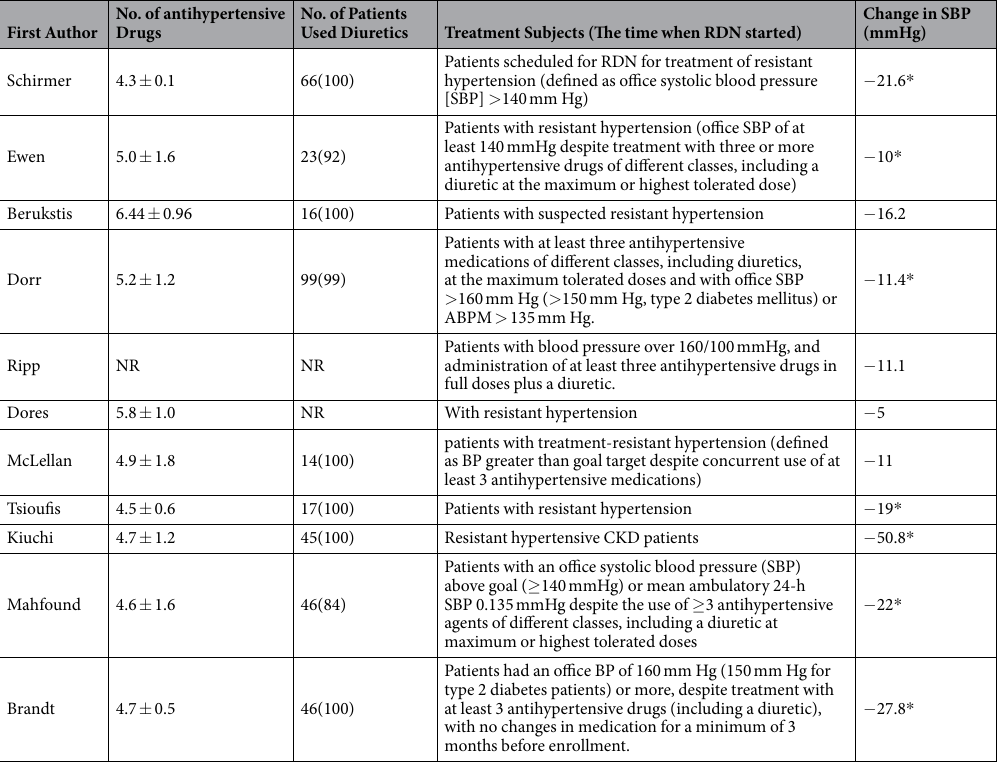
Table 2. Medications, treatment subjects and blood pressure control of included studies with 6-month follow-up. Values are mean ± SD or n (%). No.: number; RDN: renal denervation; SBP: systolic blood pressure; NR: not reported. * Indicates that the change is significant (p <